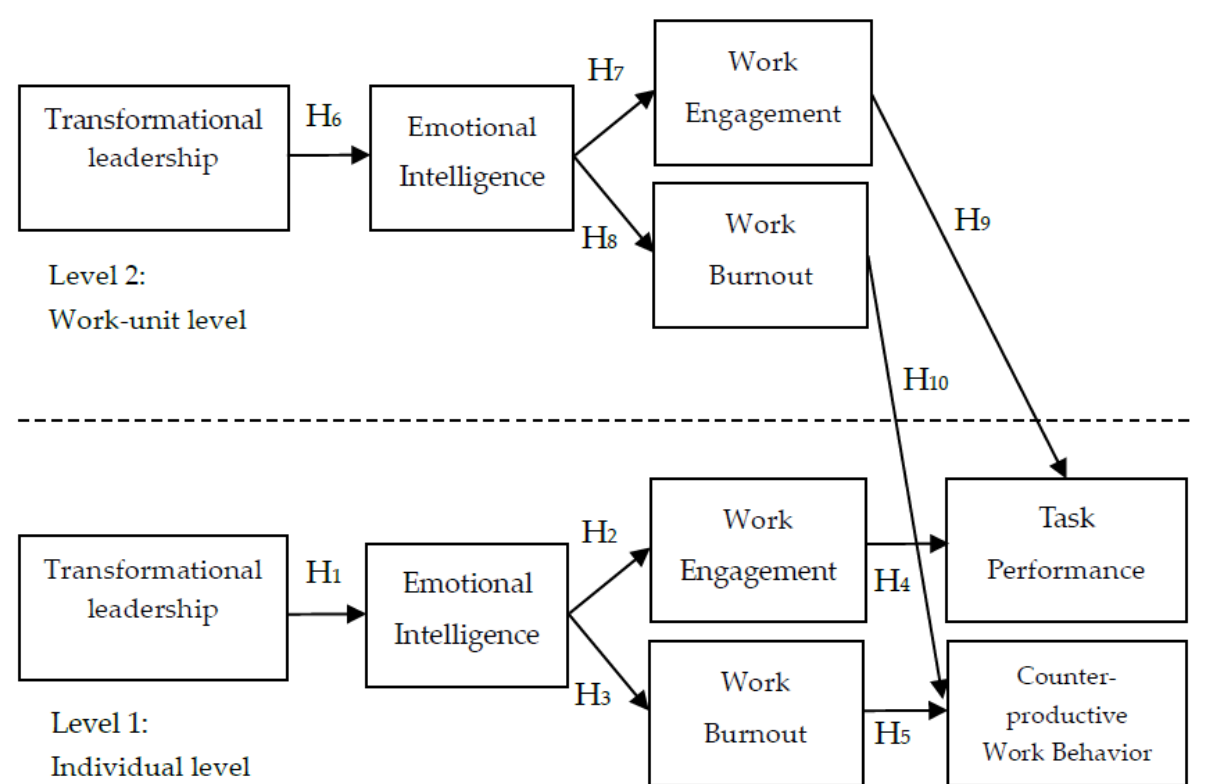
Figure 1. The MGCM of the present research.